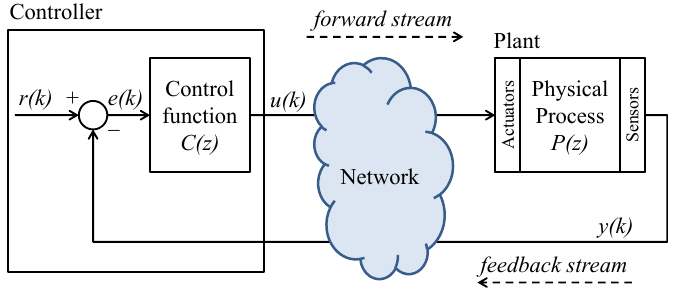
Figure 1. Networked Control Systems (NCS)